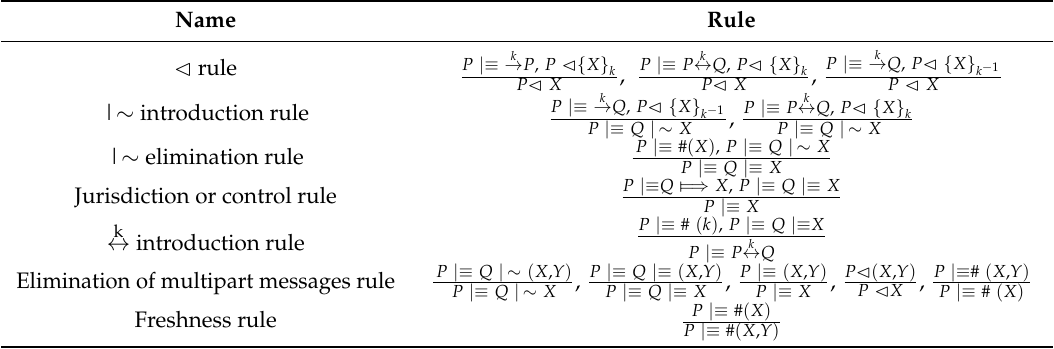
Table 10. Some primary BAN logic postulates.